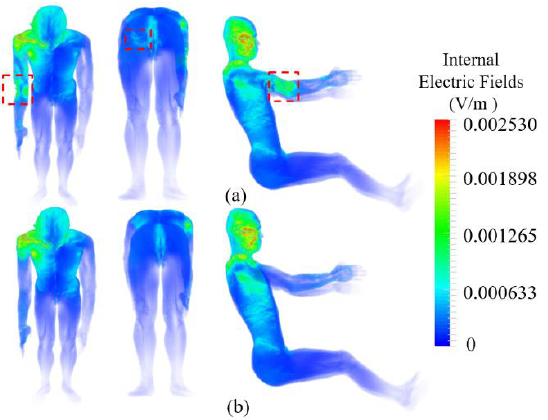
Figure 9. Electric field distribution in the driver model for the aluminum vehicle ( a ) with both the woofer and tweeter and ( b ) without the loudspeakers.